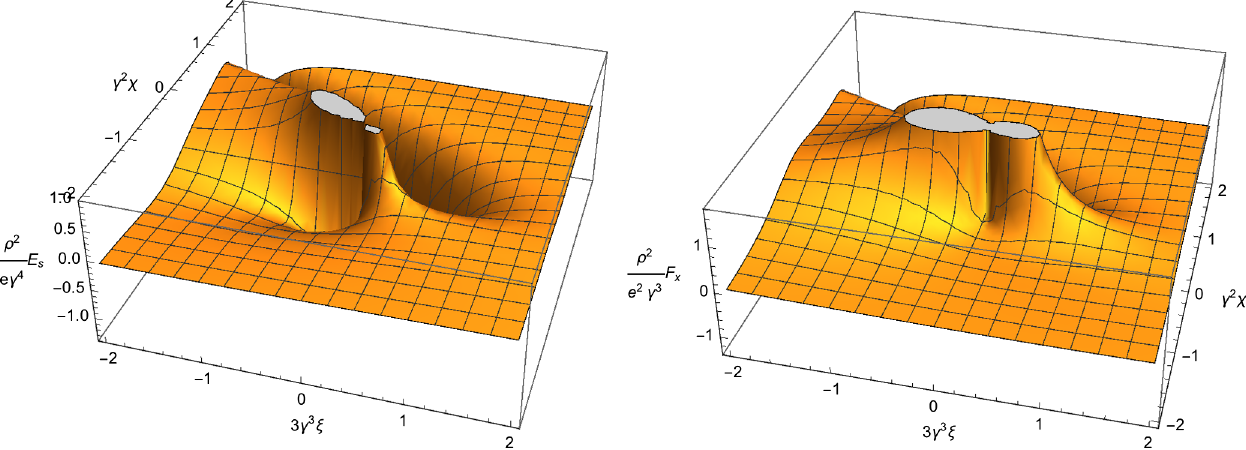
ρ 2 =e 2 γ 3 (right) as a function of μ ¼ 3 γ 3 ξ and ν ¼ γ 2 χ x